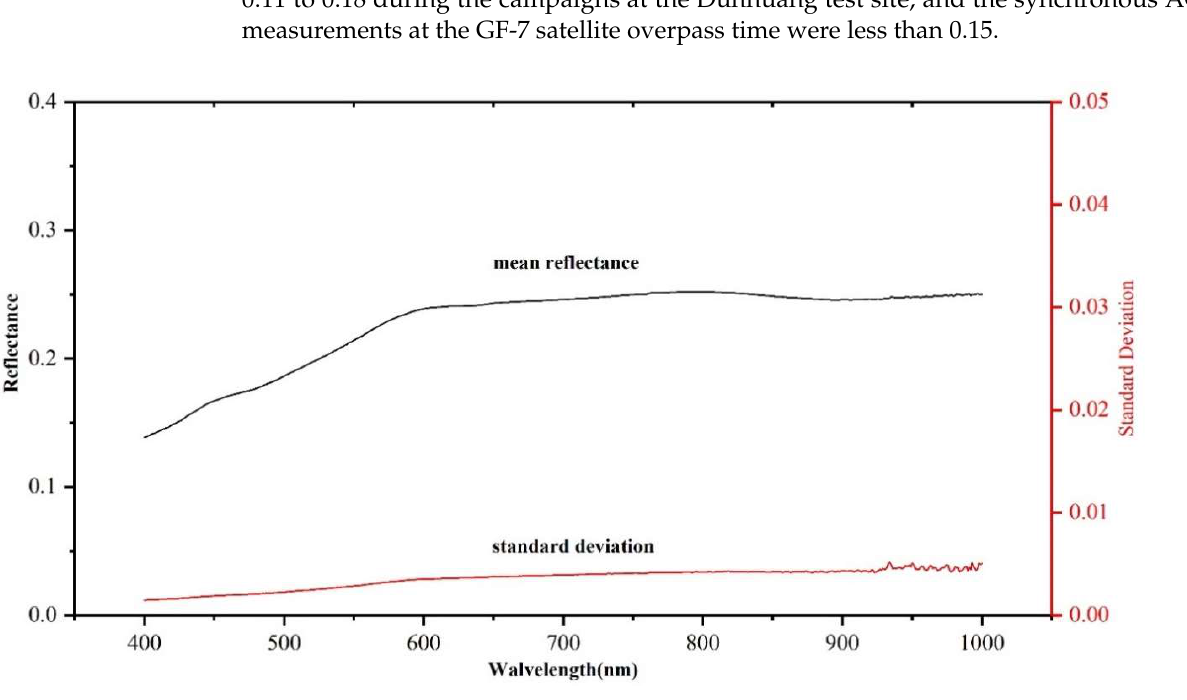
Table 7. Solar–target–satellite acquisition geometric conditions of the GF7 satellite at the Dunhuang site.